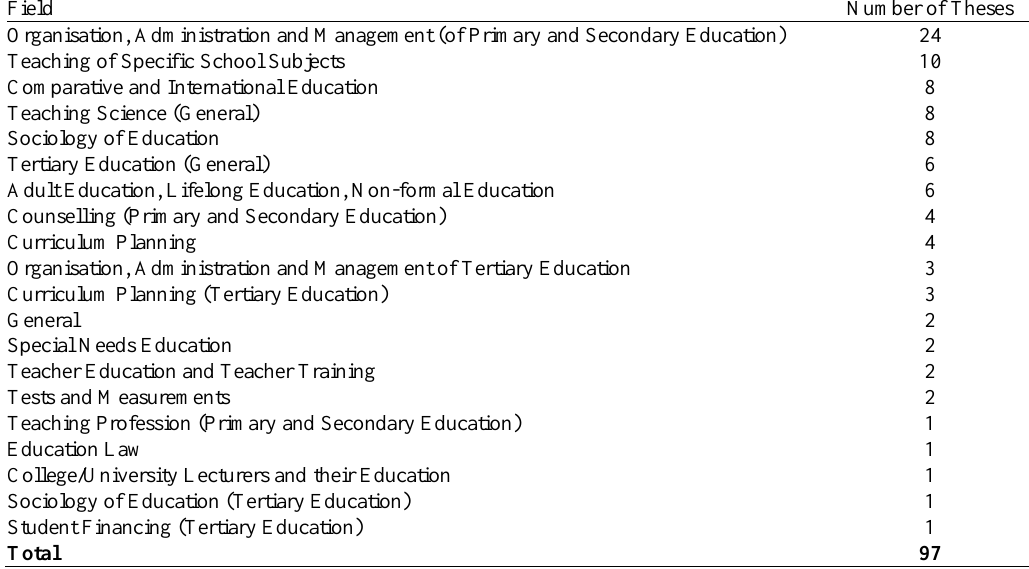
Table 1 Doctoral theses produced in South Africa in 2008 in various fields of education